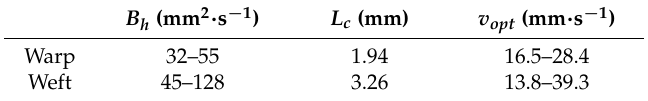
Table 1. Summary of capillary characterization of TG15N fabric with